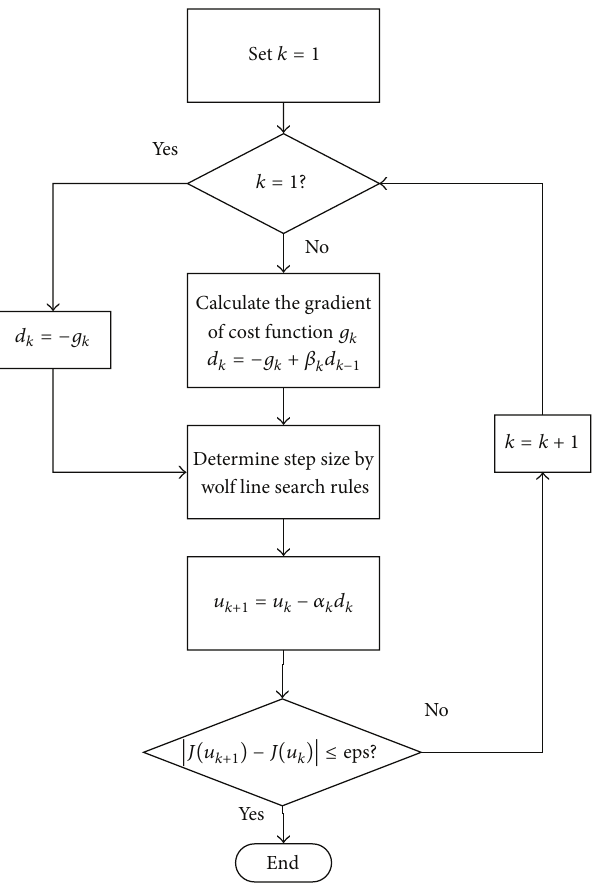
Figure 2: Conjugate gradient algorithm